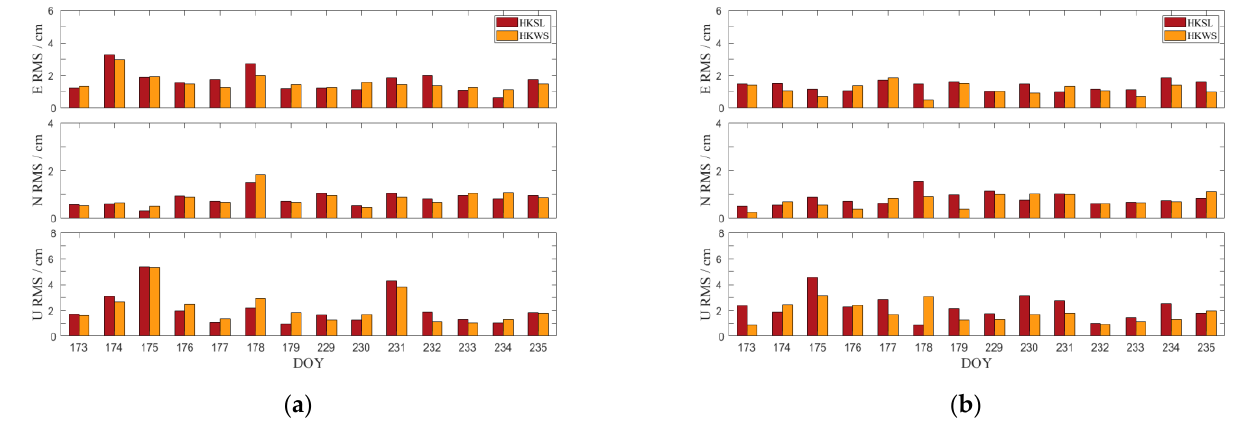
Figure 3. ( a ) Real-time static GPS PPP error; ( b ) Real-time static multi-GNSS PPP error. Table 3. Real-time GPS PPP error and convergence time. Table 3. Real-time GPS PPP error and convergence